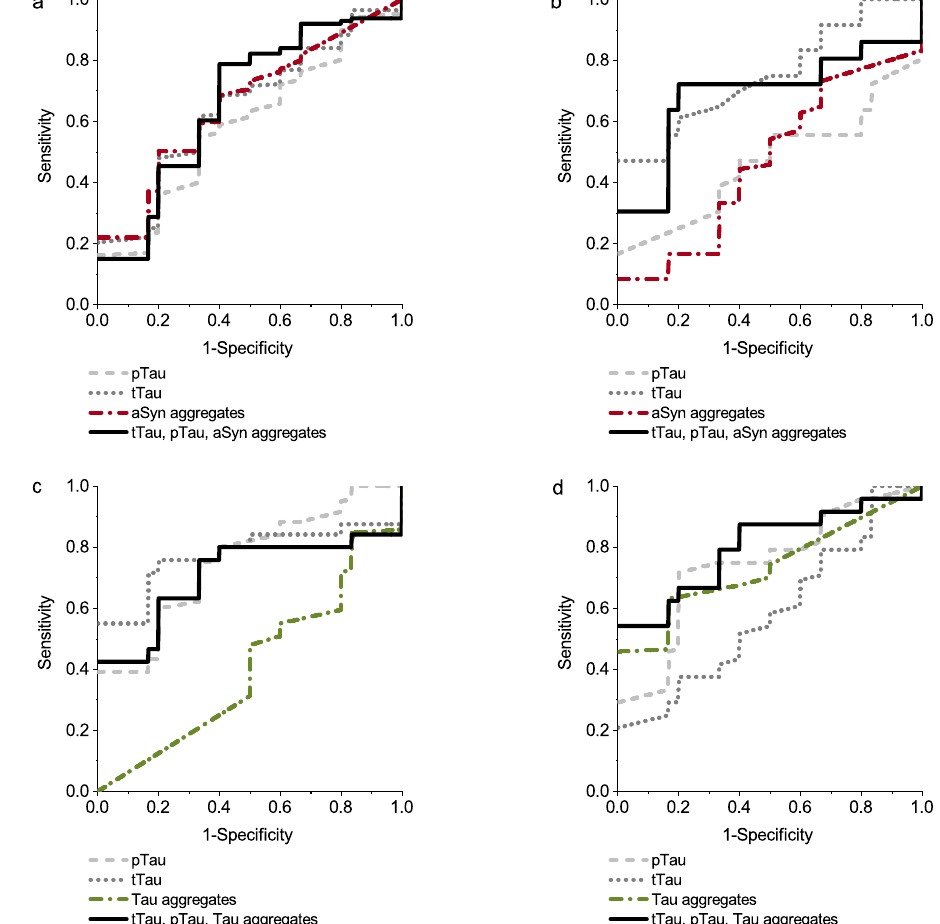
Fig. 10 ROC of pTau, tTau, aSyn and Tau aggregates and their combination. We compared the performance of different biomarkers and analyzed, if the combination of biomarkers improves the discrimination of neurodegenerative diseases compared to normal control ( a : PD vs. N, b : DLB vs. N, c : AD vs. N, d : PSP vs. N). Sensitivity, Speci fi city and AUC values are listed in Table